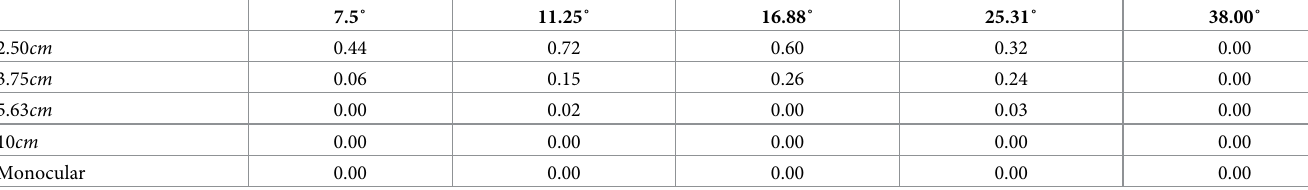
Table 3. Values of M data (mean number of strikes per trial) used for optimisation. Columns show stimulus diameter; rows show stimulus stereoscopic distance. For the top 3x4 cells (distances 2.5-5.63cm and sizes less than 38˚), data was derived from [10] by taking the difference between the total number of strikes recorded for crossed vs uncrossed trials for the given stimulus, divided by the total number of times each stimulus was presented ( N = 68). This was non-negative in all cases except distance trials 5.63cm and size 16.88˚, where it was -0.04 Zeros for size = 38˚, distance = 10cm and monocular stimuli are synthetic data included to force the optimisation to choose parameter values which predict very low strike rates for these conditions, in keeping with our observations.